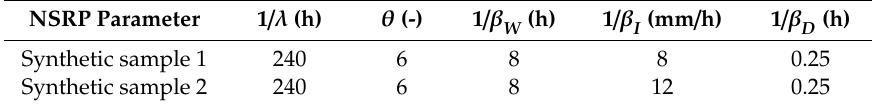
Table 2. NSRP parameters for two synthetic samples analyzed in the validation step.